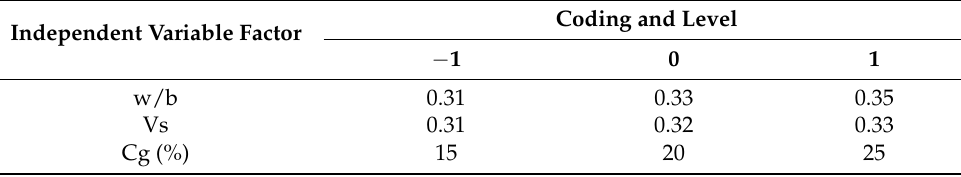
Table 3. Factors and factor levels of independent variables for the experimental